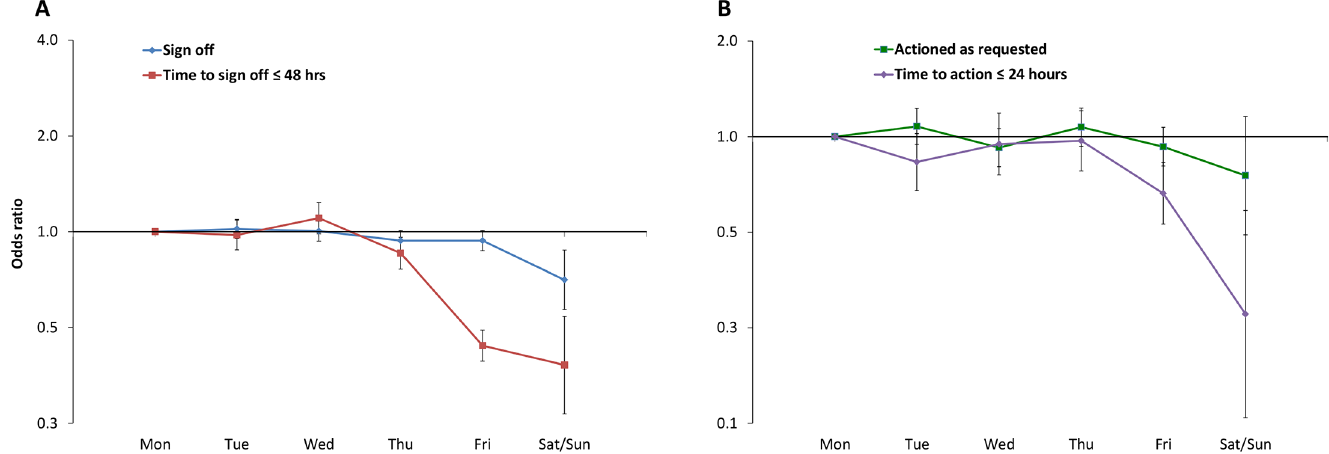
Fig 4. GEE model for day of the week. A: Sign-off and time taken to sign-off in (cid:1) 48 hours; B: Action and time to action as requested in (cid:1) 24 hours. ORs (95% CI) from the GEE model described in S2 Appendix. Monday is the reference category and the y-axis uses a logarithmic scale.